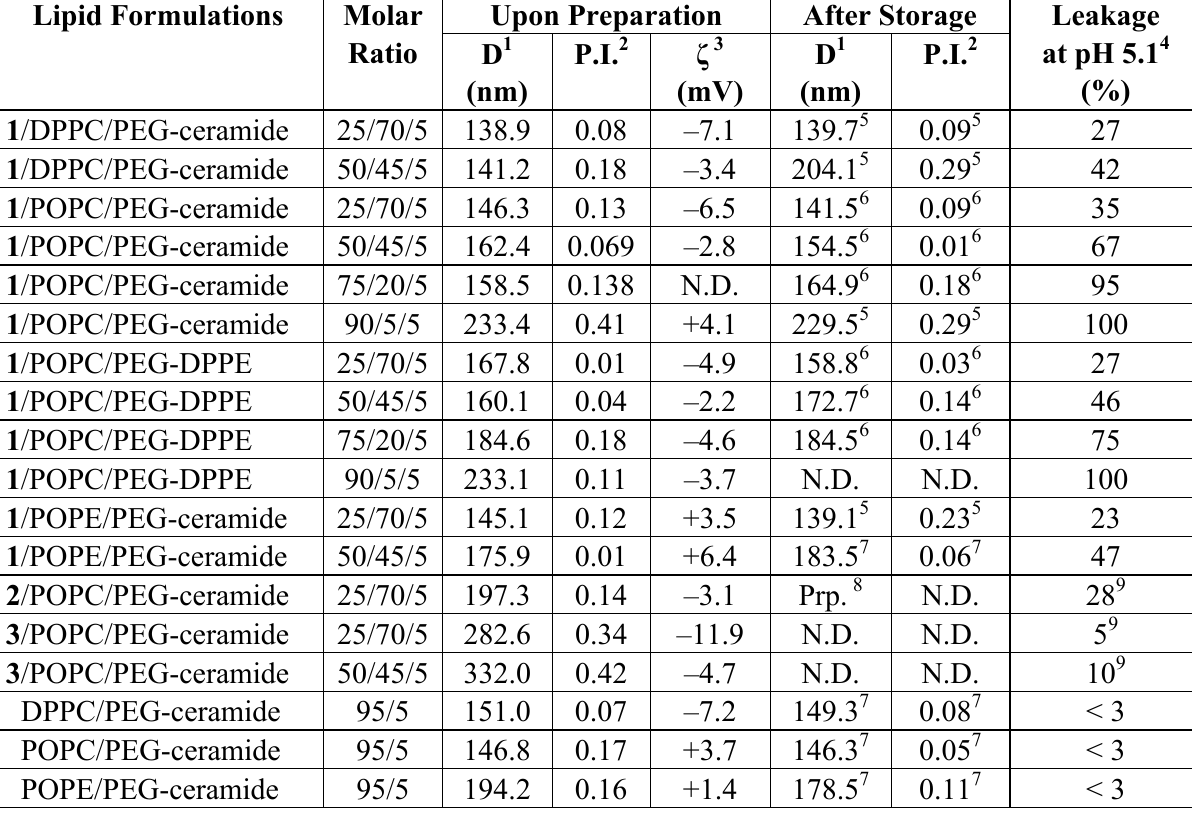
Table 1. Size, ζ -potential and pH-triggered leakage of PEGylated liposomes. Lipid